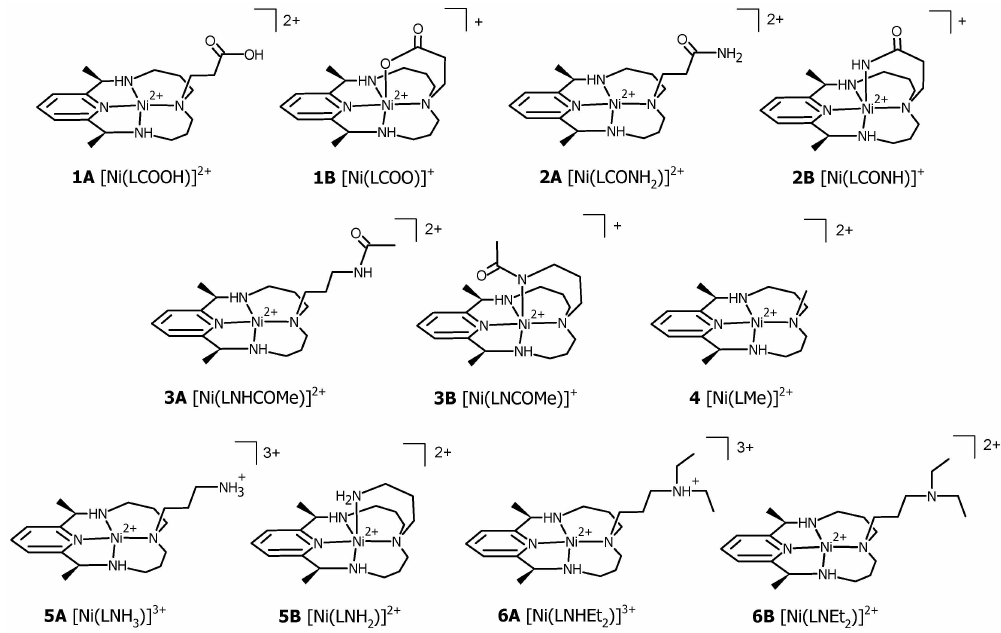
Figure 1. Molecular structures of Ni(II)–PyMAC (pyridine-tetraazamacrocycle) complex ions 1 – 6 . A and B denote protonated and deprotonated forms, respectively (except structure 4